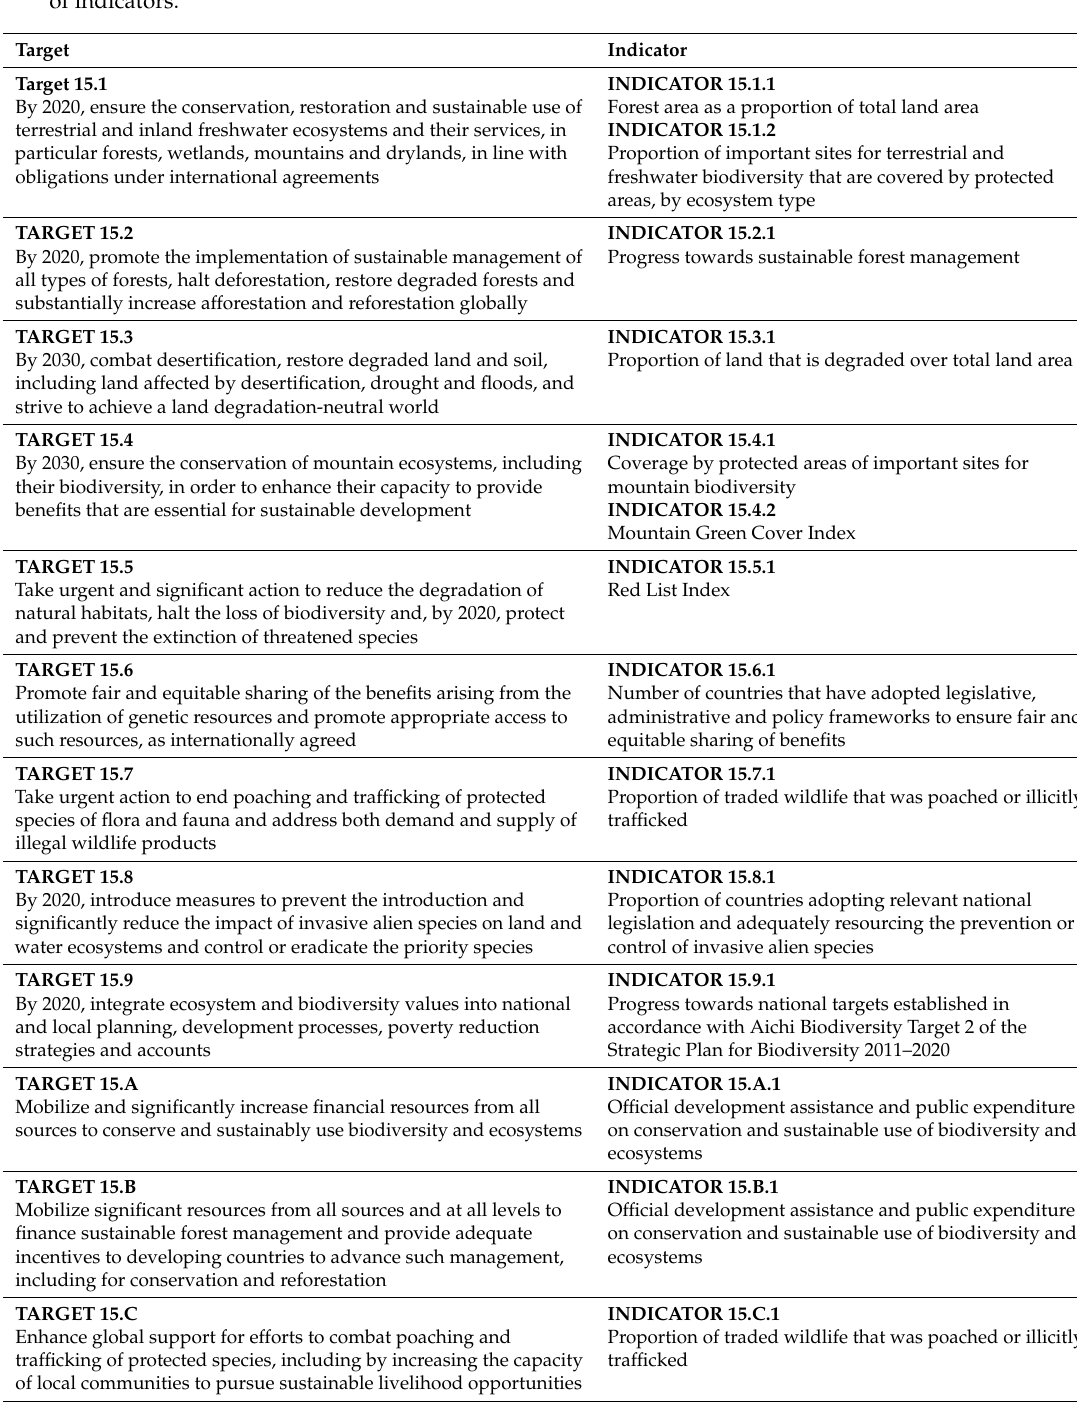
Table A1. SDG15 of the Agenda 2030 aims to protect, restore, and promote the sustainable use of terrestrial ecosystems, sustainably manage forests, combat desertification, and halt and reverse land degradation and halt biodiversity loss. This goal has 12 targets. Each target can be assessed by a set of